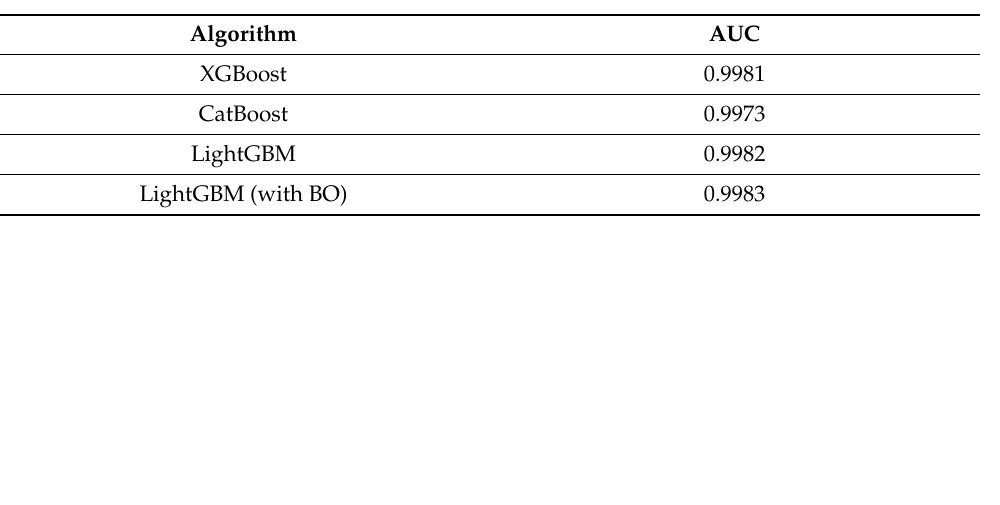
Table 4. AUC of ML algorithms in